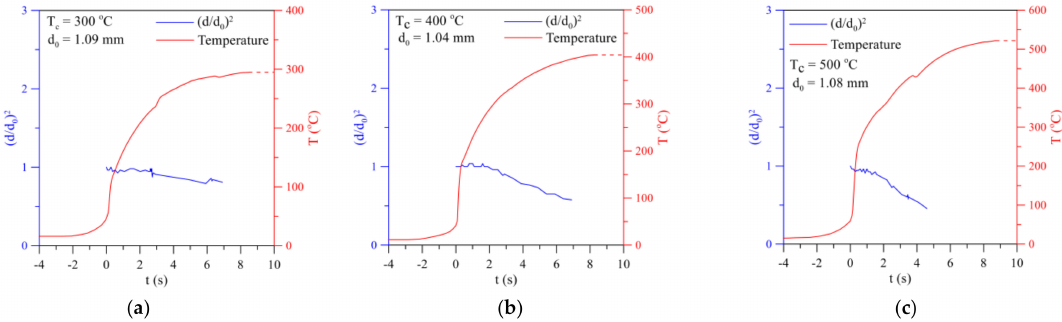
Figure 5. The plots of dimensionless droplet diameter square ( d / d 0 ) 2 versus time and temperature versus time for pure heavy fuel oil at different ambient temperatures ( a ) 300, ( b ) 400, and ( c ) 500 ◦